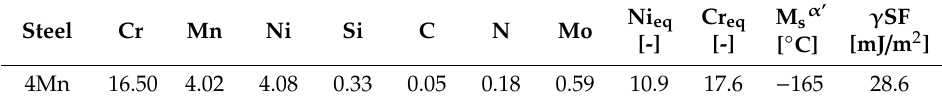
Table 1. Chemical analysis of the laboratory steel 4Mn in wt% with the calculated values of nickel and chromium equivalents (Ni eq ; Cr eq ), of M s α ’ temperature and stacking fault energy ( γ SF